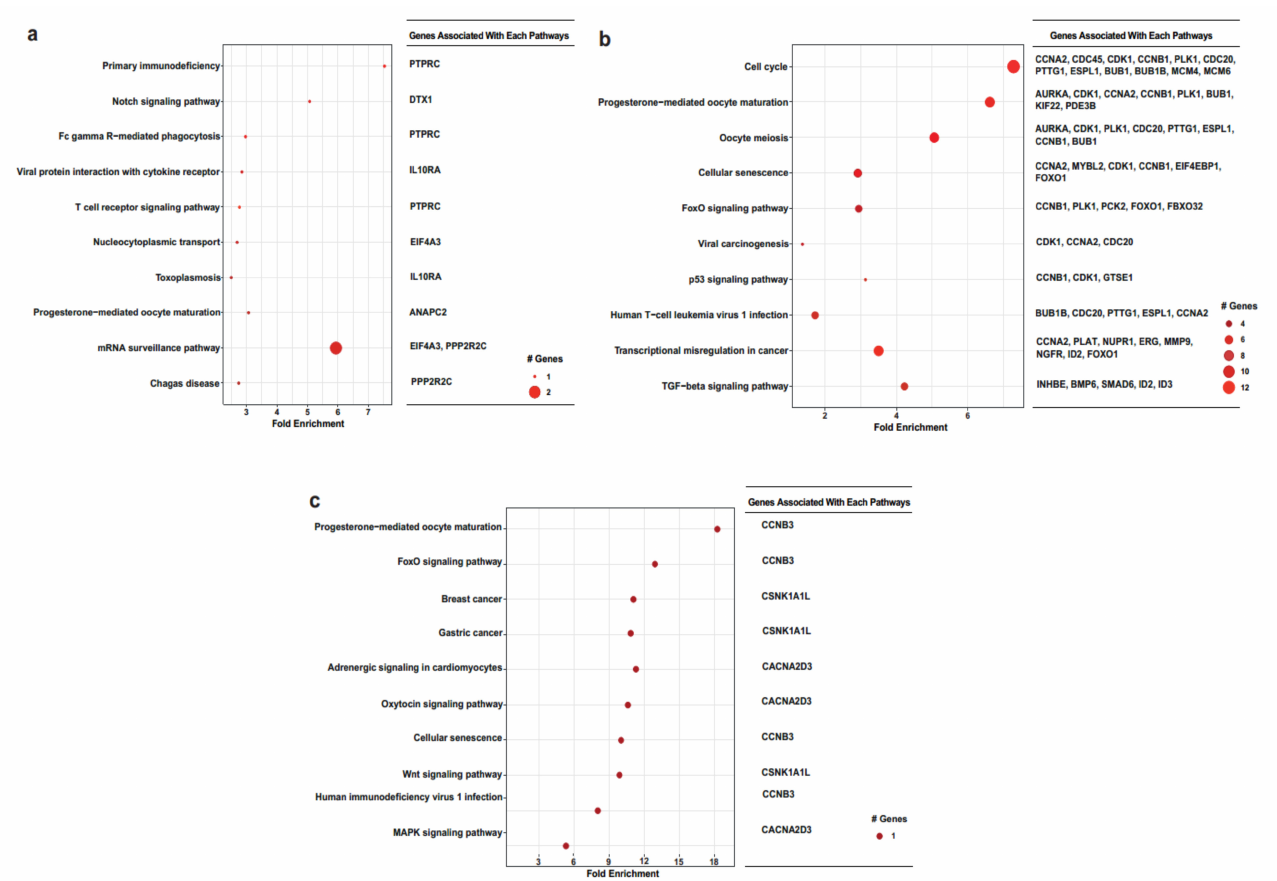
Figure 6. Biological pathways associated with the exposure of the different environmental doses of BPA (10 nM ( a ) and 100 nM ( b )) dysregulated genes, along with shared common DEGs of these two doses ( c